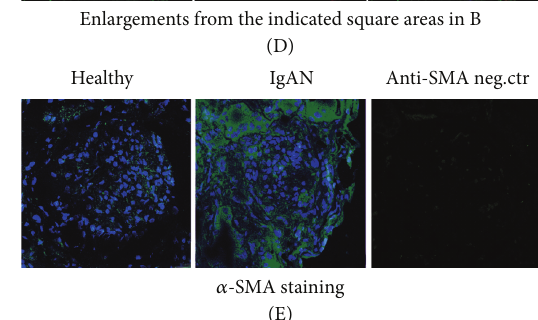
Figure 9: Nephrin and 𝛼 -SMA expression in kidney biopsies from a normal individual and a patient carrying a Finnish mutation p.S569R (c.1707C > A) (NPHS1) and in IgAN. Immunofluorescence and confocal analysis were carried out as described in Section 2. (A) Nephrin expression in normal (WT) (a) and NPHS1 kidney (b). (c) shows the antibody negative control. (B) Negative control for 𝛼 -SMA (a) expression and WT1 (b) antibodies and their merged signals (d). (C) 𝛼 -SMA and WT1 expression in normal (WT) and NPHS1 kidney (WT a-b and p.S569R d-e) and their merged signal (c-f). 𝛼 -SMA colocalizes with WT1 indicating its podocyte origin. (D) Enlarged particular of panel (c) showing the colocalization of 𝛼 -SMA and WT1 in NPHS1 kidney tissue and their merged signals (a, b, and c). (E) 𝛼 -SMA expression in healthy or IgA nephropaty (IgAN) renal biopsy. The technical details are described in Section 2. The figure shows a typical experiment of at least three performed under the same